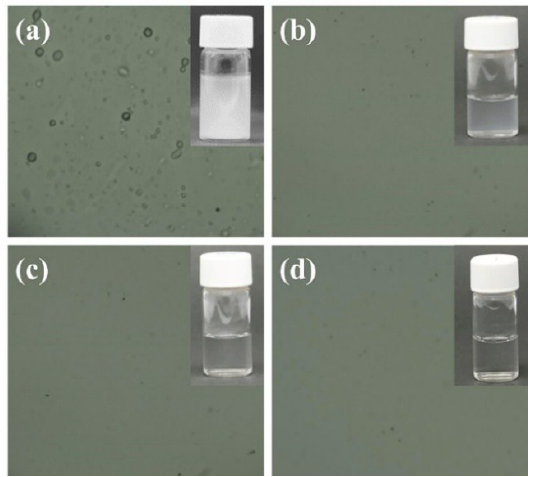
Figure 6. Demonstration of permeate: ( a ) oil-water; ( b ) TiO 2 /GO/rTAC-p; ( c ) TiO 2 /GO/rTAC-n and ( d ) TiO 2 /GO/rTAC-np.